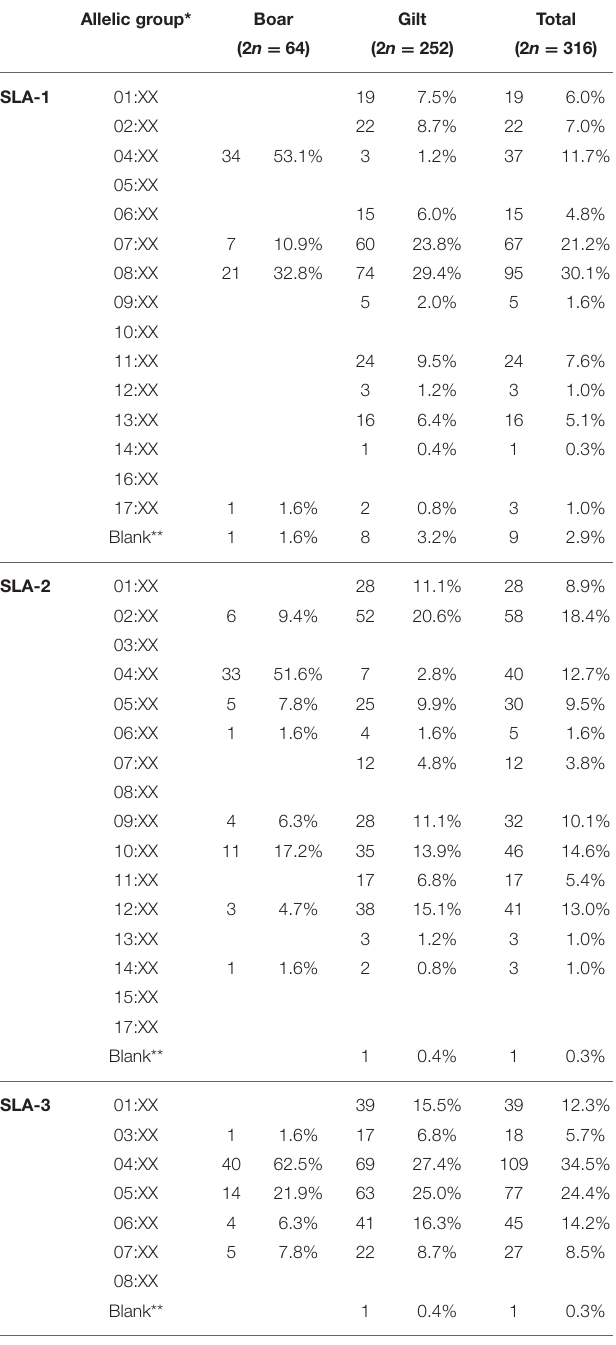
TABLE 1 | Frequency of SLA class I allelic groups.